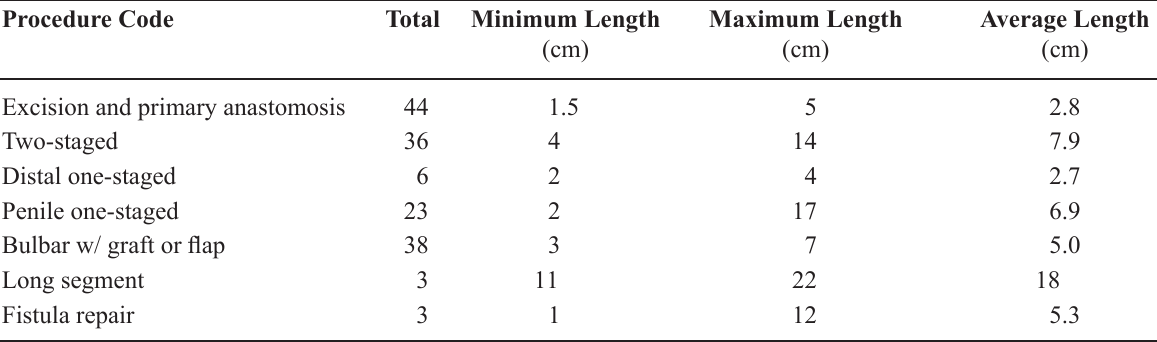
Table 2 – Stricture length by type of surgical